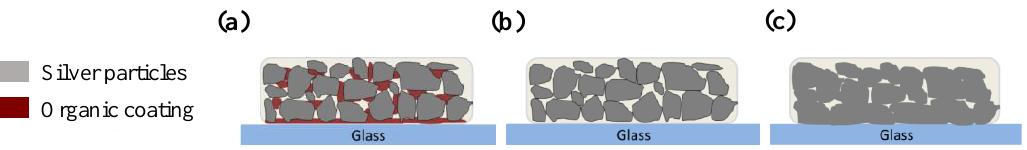
Figure 6. SEM images of the cross section of silver films based on NP ink: ( a ) Heat cured in 140 °C for 30 min; ( b ) UV cured at D = 25 cm for 480 s.